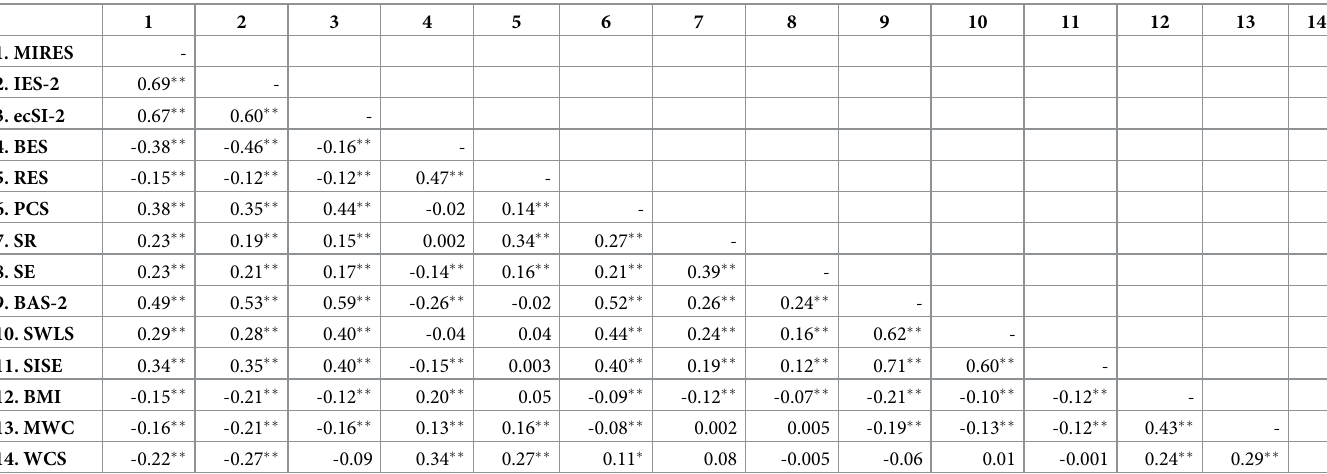
Table 5. Bivariate correlations among all constructs measured in the US sample.